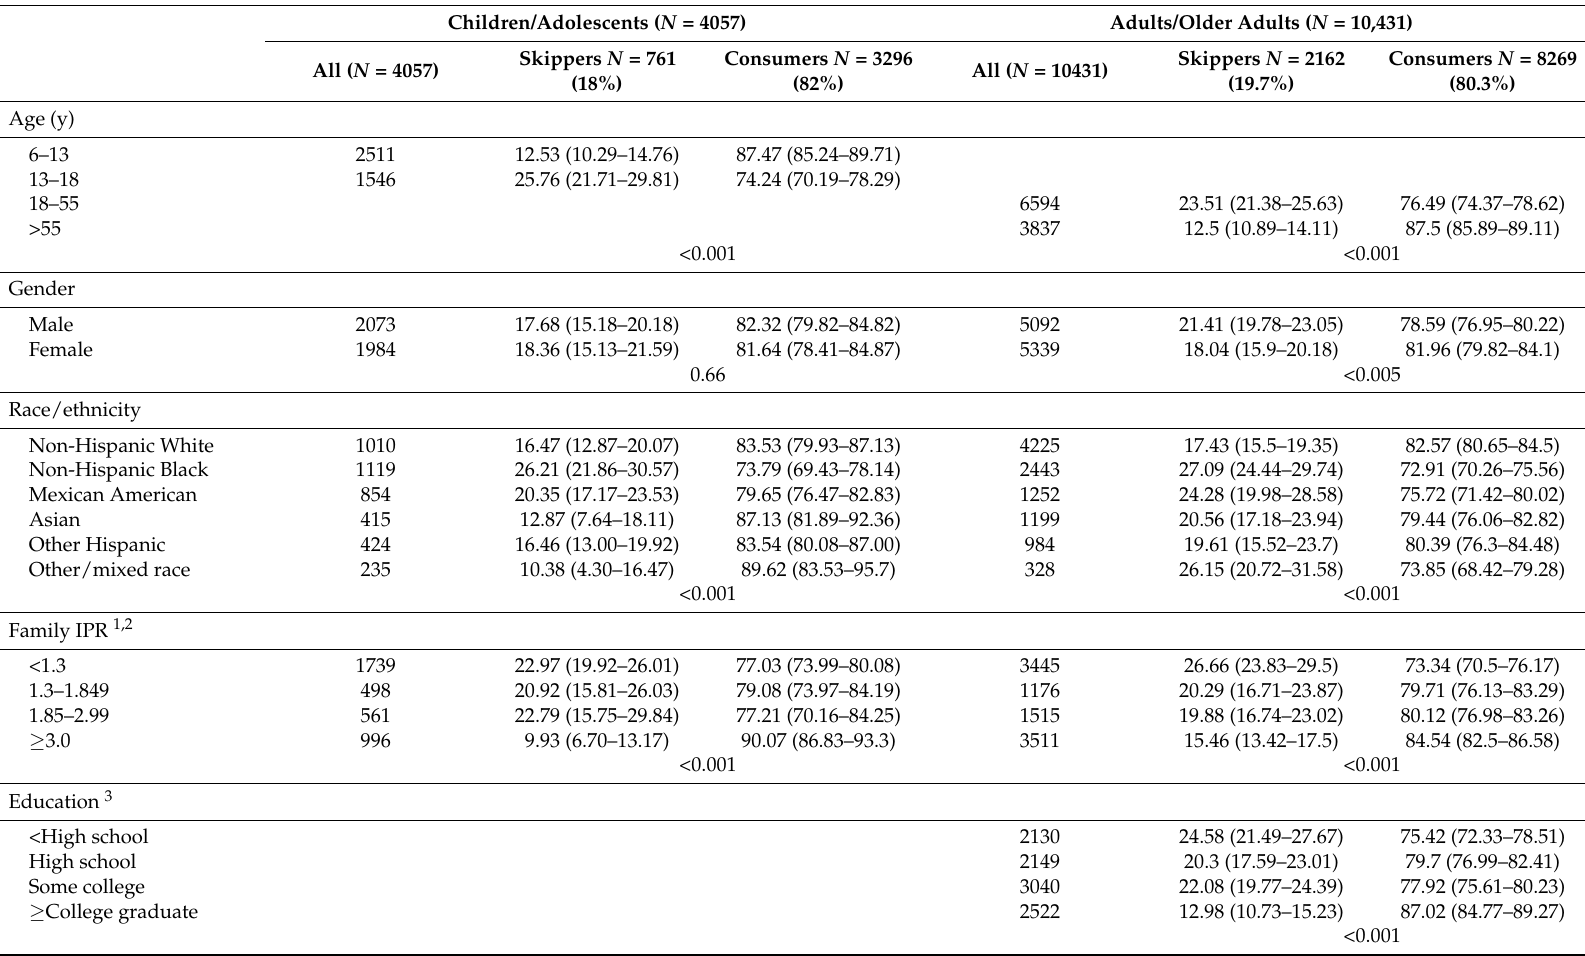
Table 1. Frequency (%) and 95% confidence limits of breakfast consumption by age group and by key